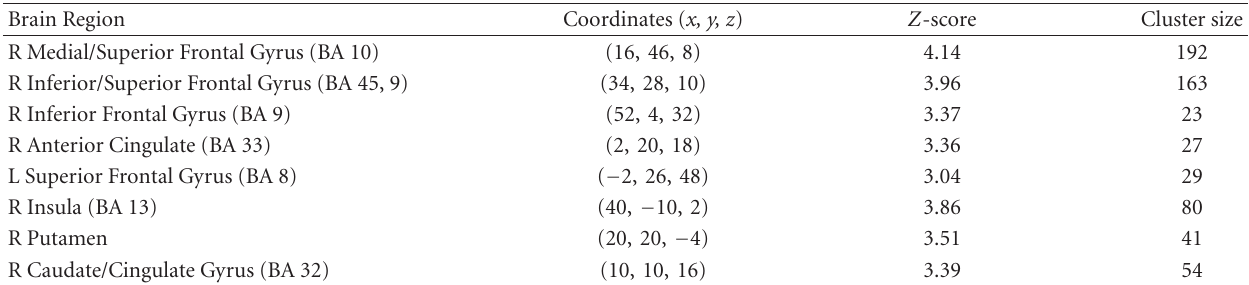
Table 4: Brain regions exhibiting a greater di ff erence in activity during the before versus after rehabilitation fMRI session in the comparison between past and control